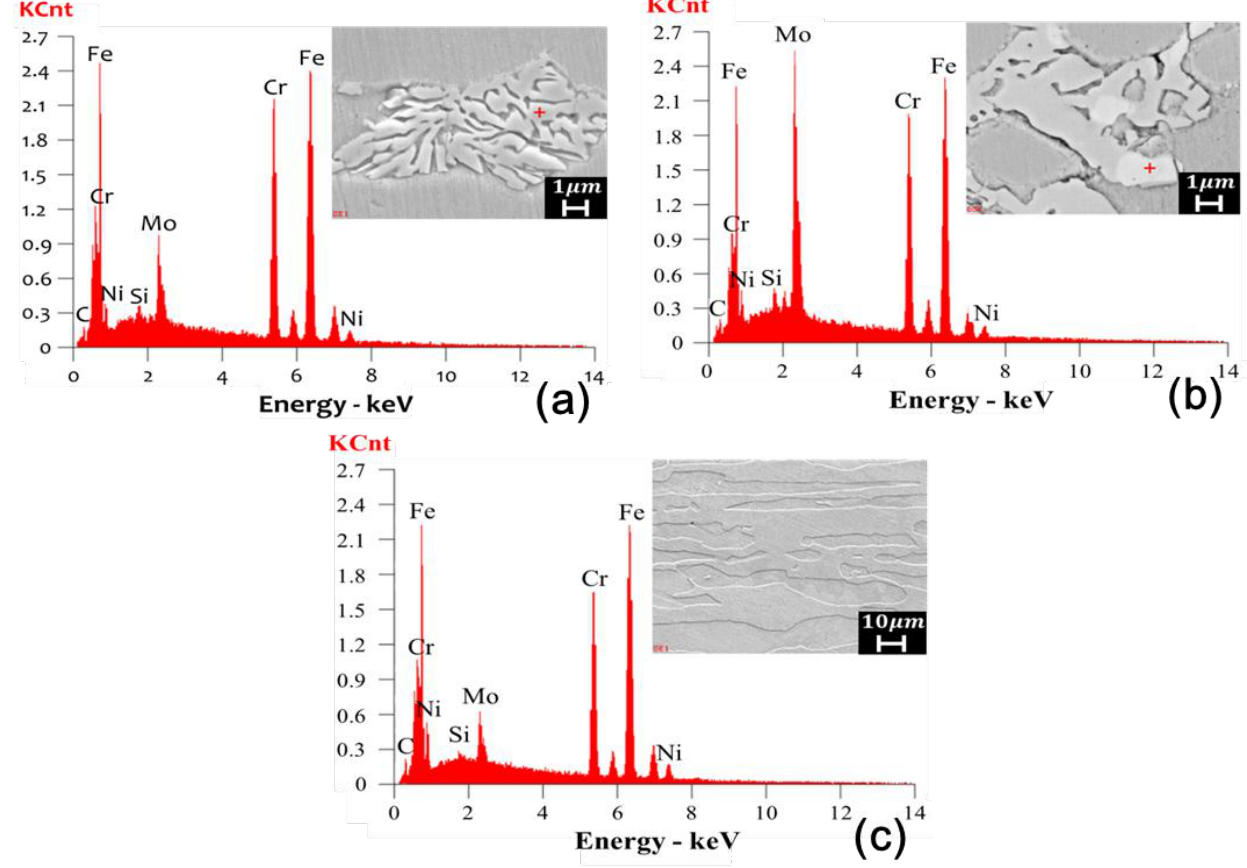
Figure 8. EDX analysis of SDSS ( a ) σ phase; ( b ) χ phase and ( c ) SDSS.